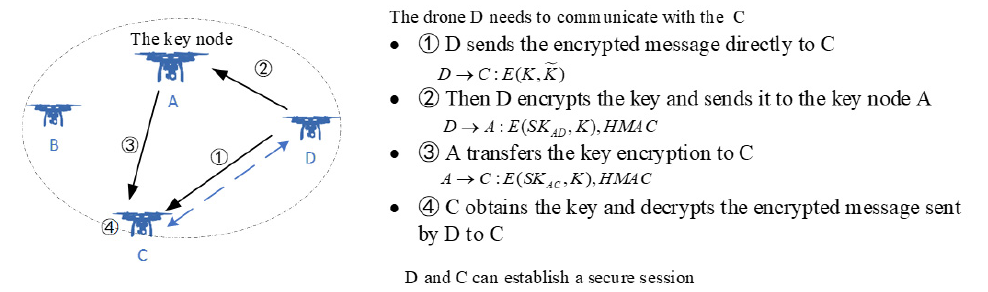
Figure 6. Mutual authentication between UAVs.